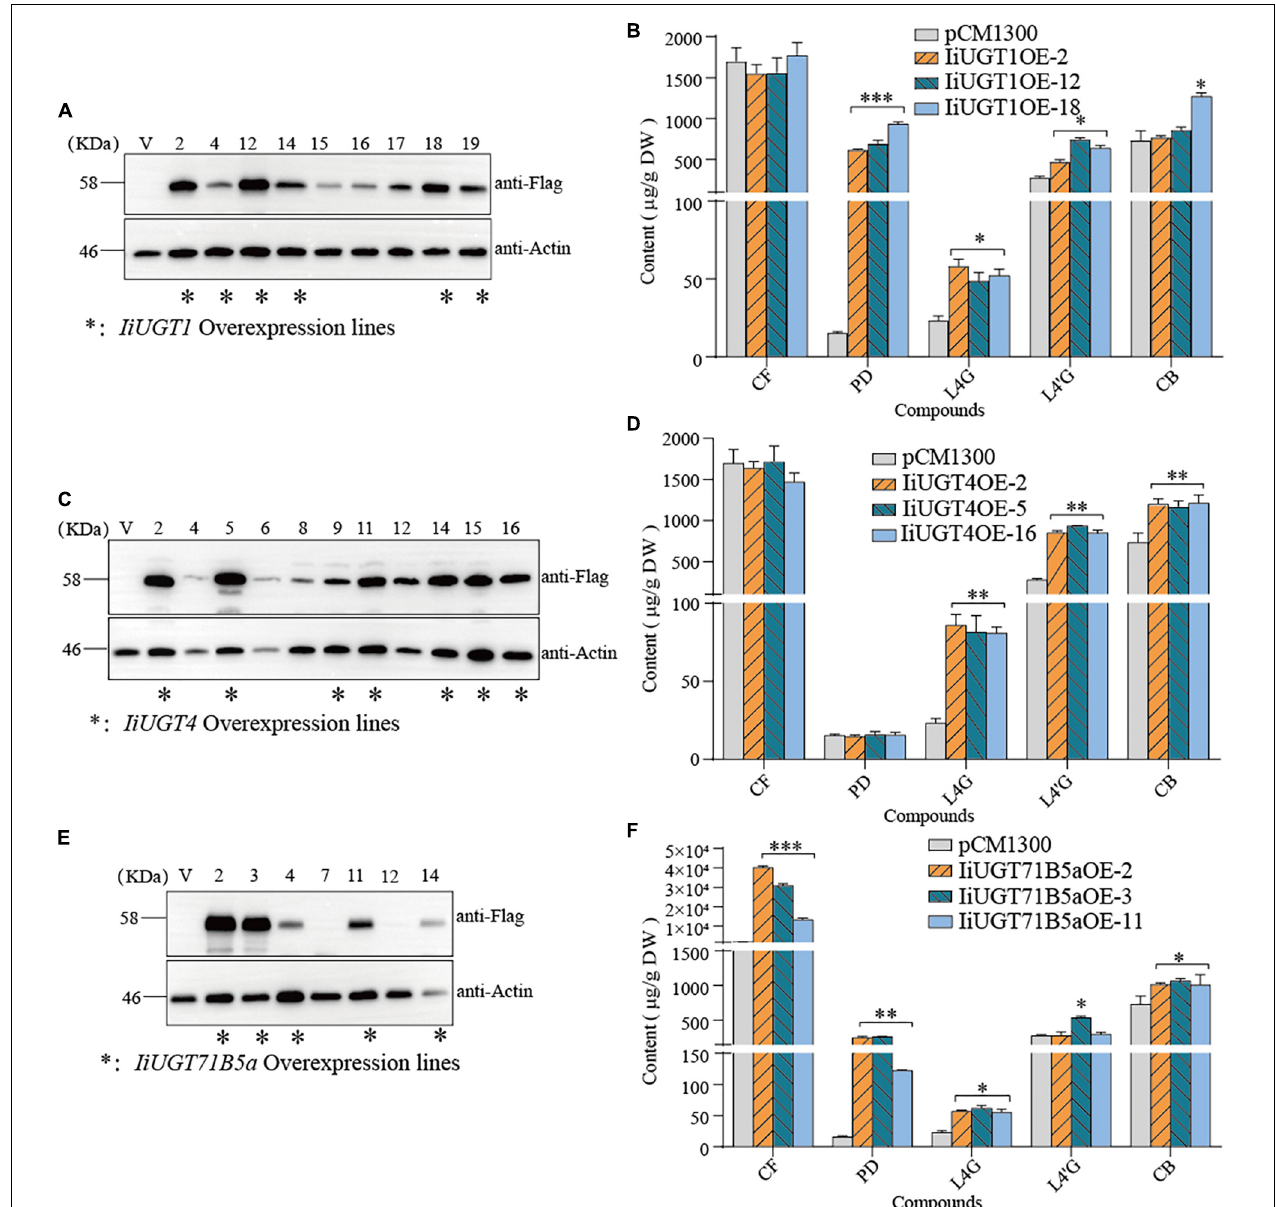
FIGURE 7 | Overexpression of IiUGTs in I. indigotica hairy roots. (A,C,E) Western-blot analysis showing IiUGT transcript expression. Effect of IiUGT1 (B) , IiUGT4 (D) and IiUGT71B5a (F) overexpressing on the contents of coniferin (CF), pinoresinol diglucoside (PD), lariciresinol-4- O - β -D-glucoside (L4G), lariciresinol-4 (cid:48) - O - β -D-glucoside (L4 (cid:48) G), clemastanin B (CB). Standard errors were calculated from three biological replicates. Statistical sinificance levels between the variable groups and the control group were calculated using one-way ANOVA test and Tukey’s multiple comparisons test ( ∗ p < 0.05, ∗∗ p < 0.01, and ∗∗∗ p < 0.001).